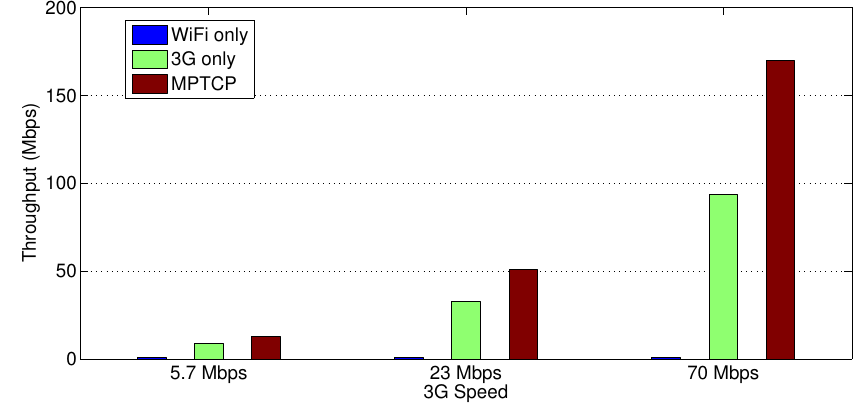
Figure 2. Throughput performance of single-path WiFi and 3G/4G versus